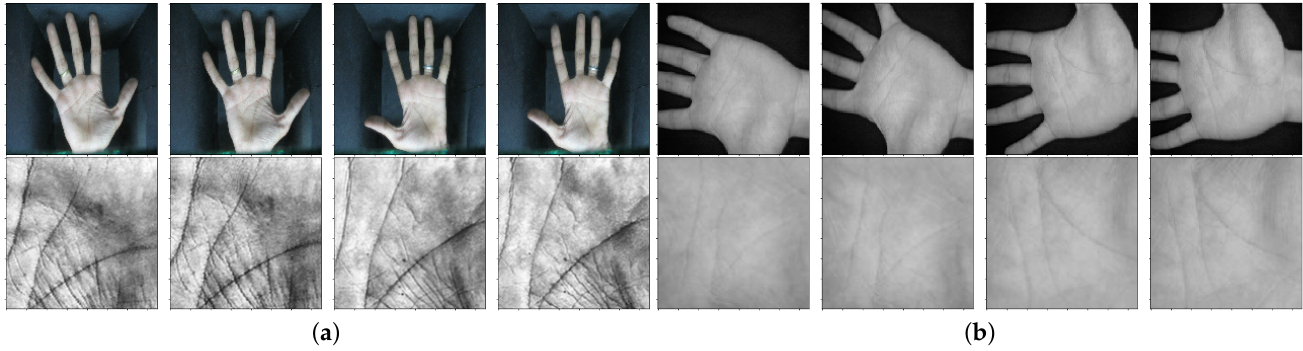
Figure 7. Samples from the left and right palmprints with their corresponding segmented region of interests (ROIs) for: ( a ) the IITD dataset, and for ( b ) the CASIA